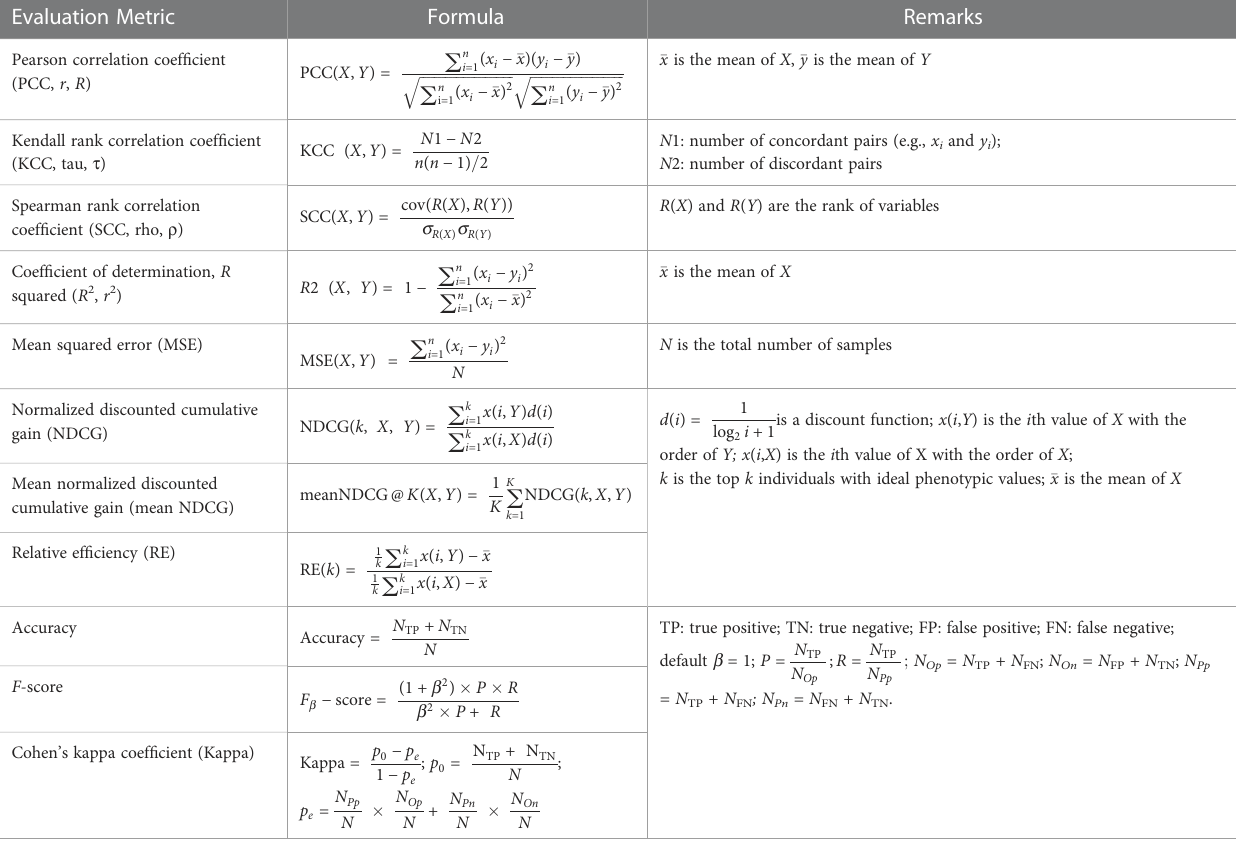
TABLE 2 Eleven metrics for model evaluation integrated into